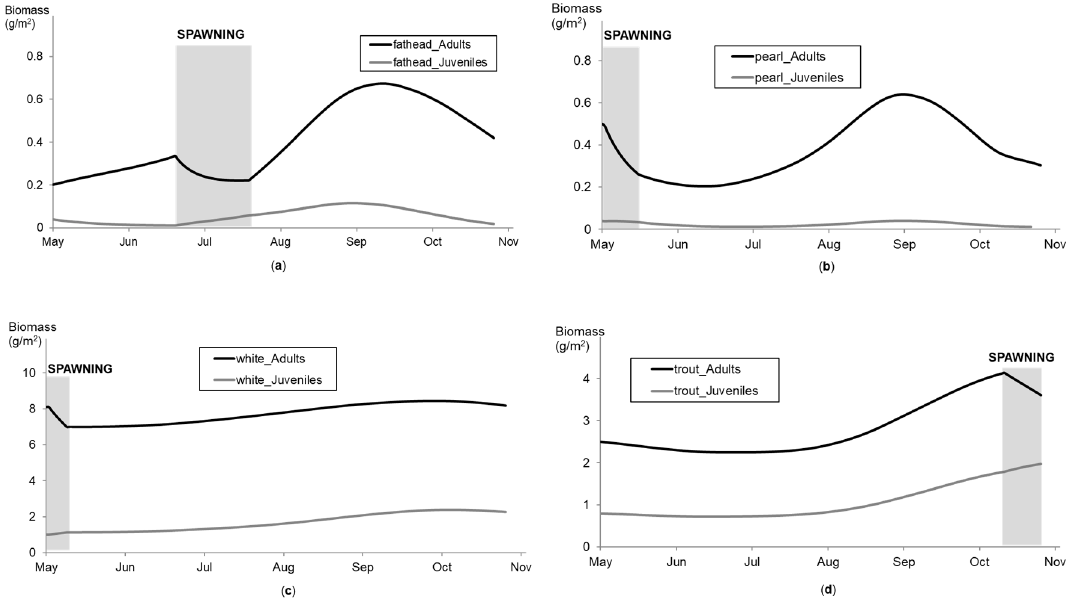
Figure 13. Simulation results for fish (lines) with the anticipated spawning added (blocks) for ( a ) fathead minnow, ( b ) pearl dace, ( c ) white sucker and ( d ) lake trout.